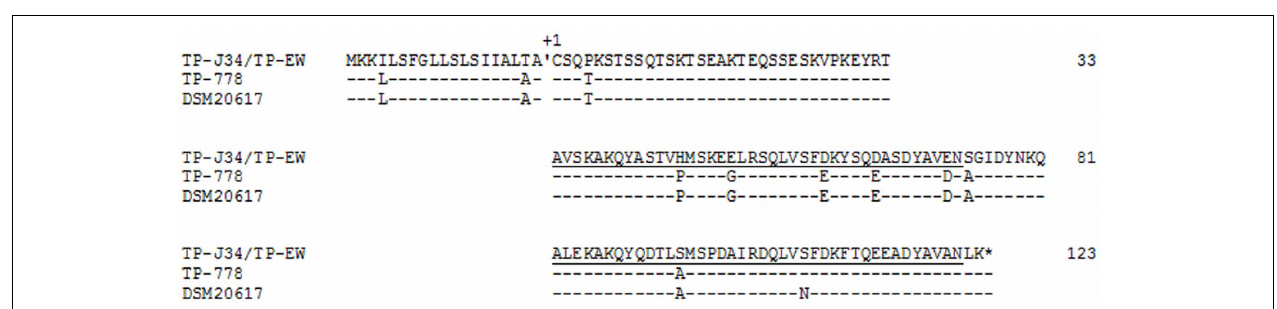
FIGURE 8 | Alignment of amino acid sequences of different Ltp proteins. The cleavage site between signal sequence and mature protein is indicated. The first Cys of the mature TP-J34 lipoprotein is marked as + 1. The two repeat regions are underlined. Amino acids identical to those of TP-J34 are indicated by